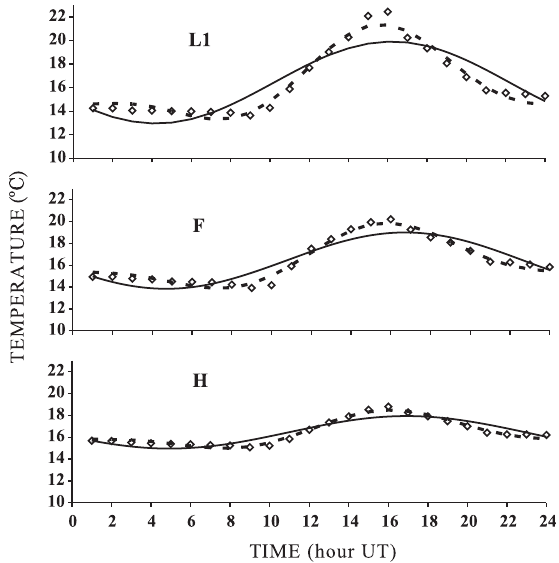
Figure 2. Time-course of temperature in the L, F and H litter sub-layers measured ( (cid:154)(cid:154)(cid:154)(cid:154)(cid:154) ) and simulated with the first ( ___ ) and the first two Fourier harmonics ( --- ) in a pine-forested Haplic Podzol on day M (moist